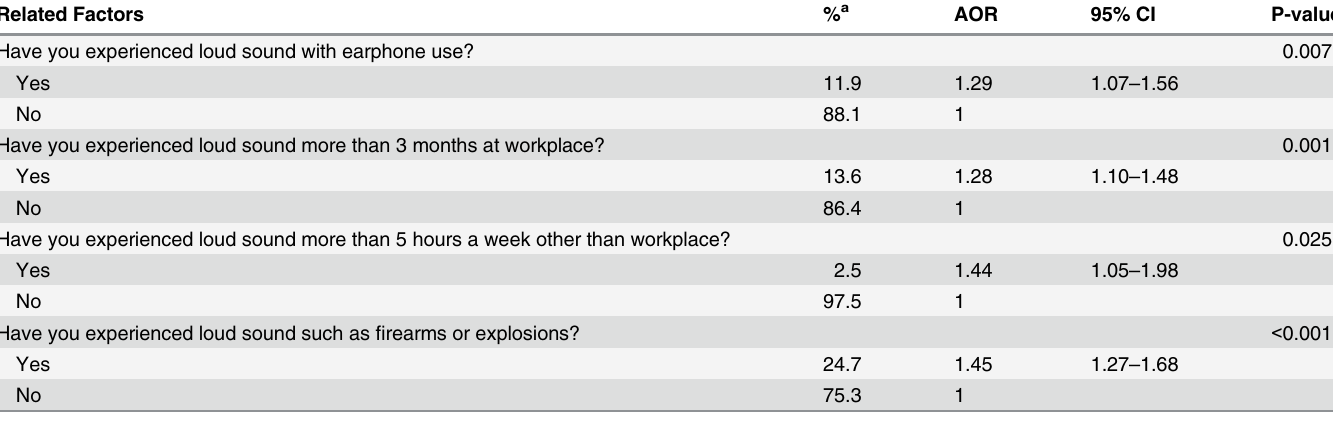
Table 3. Multiple logistic regression analysis with complex sampling of noise exposure history for tinnitus. Related